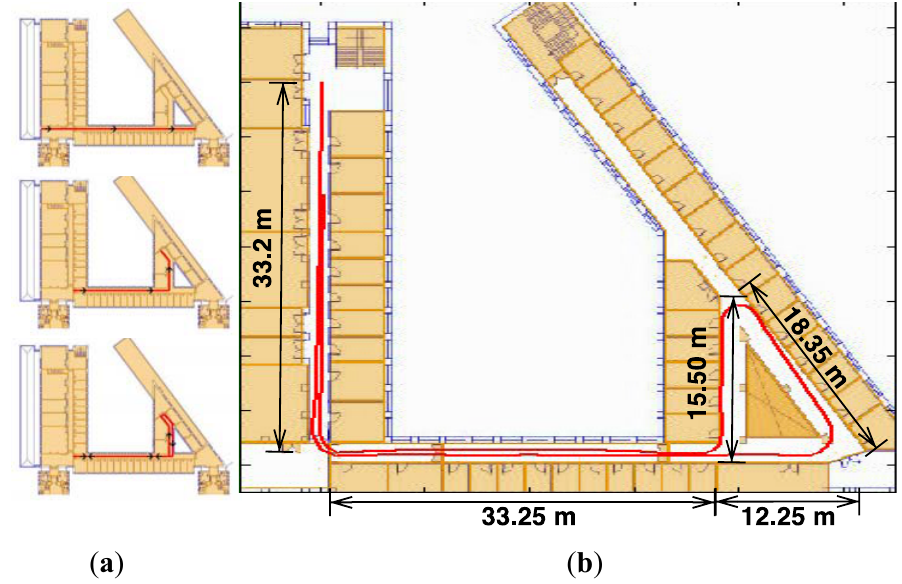
Figure 3. Location C for large-range indoor experiments, 179 m length with 540 degrees turns. ( a ) Partial shorter experiments within the same environment, see Table 1; ( b ) Real-time path